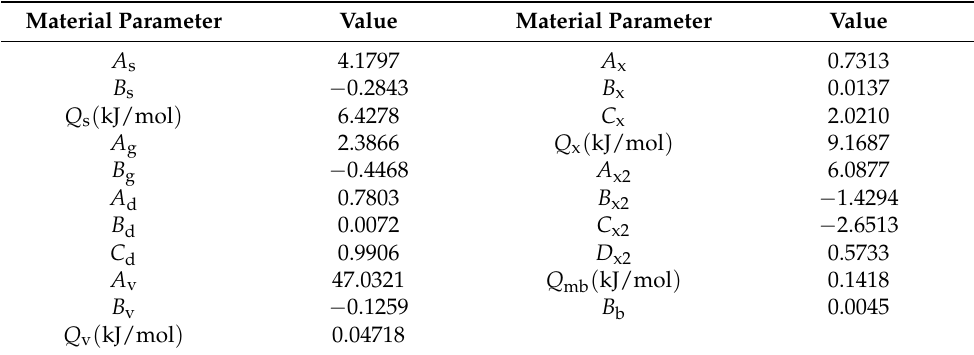
Table 1. The calibrated material